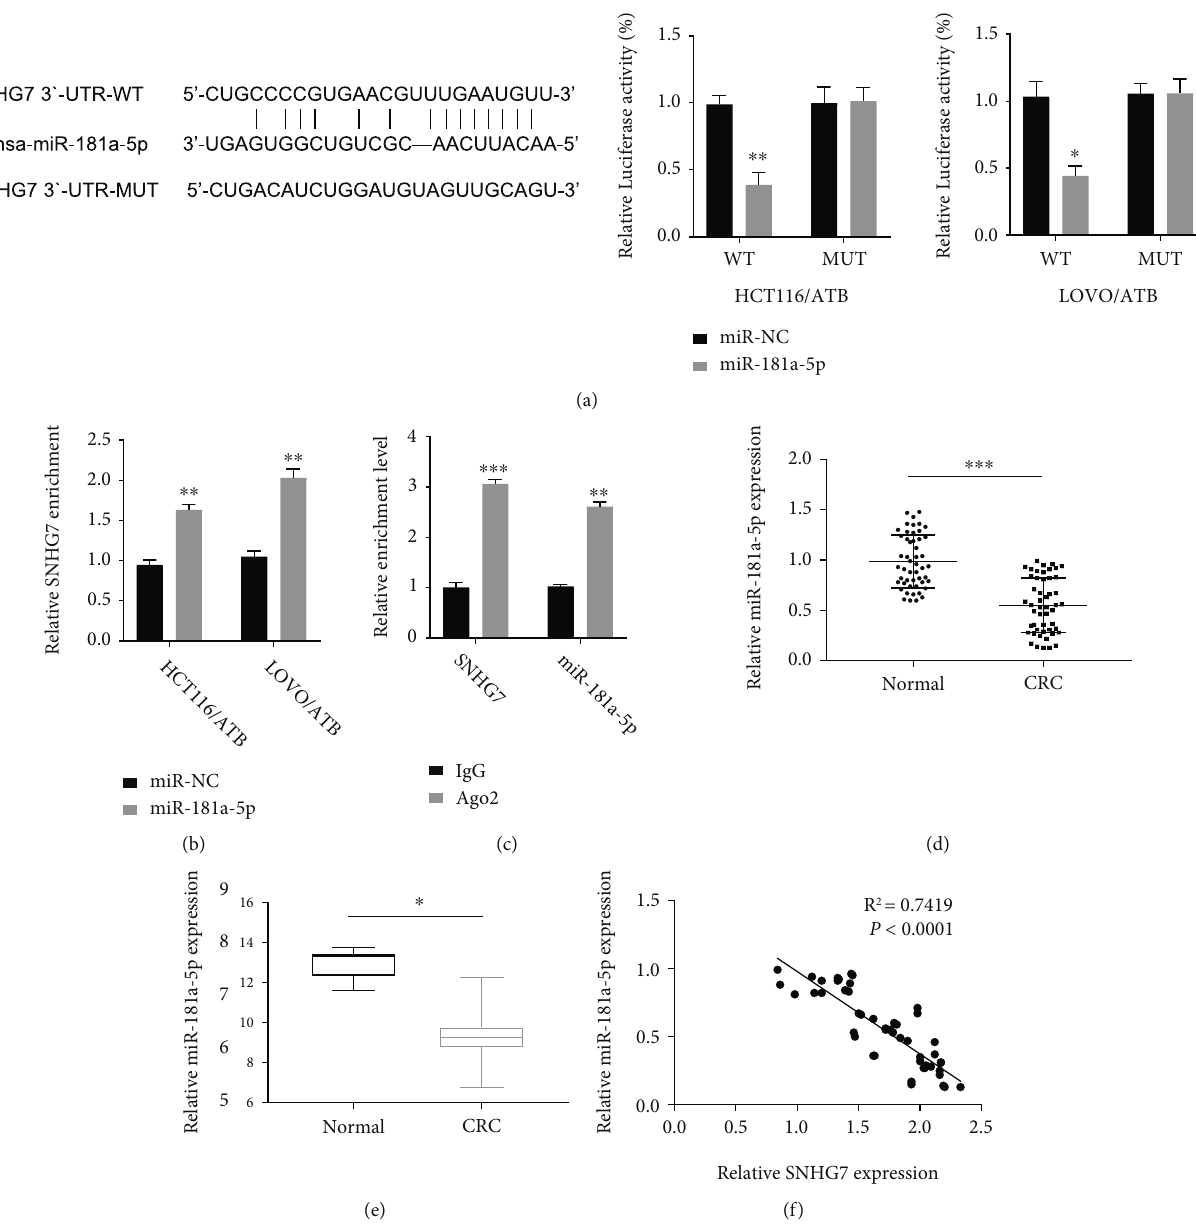
Figure 3: MiR-181a-5p is directly regulated by SNHG7. (a) Potential binding site of miR-181a-5p in SNHG7 predicted by StartBase3 and con fi rmed by Luciferase reporter assay in HCT116/ATB and LOVO/ATB cell lines. Overexpression of miR-181a-5p could inhibit Luciferase activity, but the inhibition was abolished when the potential site was mutated. (b) RNA pull-down assay showing that SNHG7 fragments were enriched e ff ectively using the miR-181a-5p probe in HCT116/ATB and LOVO/ATB cell lines. (c) RIP-qRT-PCR showing SNHG7 and miR-181a-5p fragments were enriched by Ago2 in HCT116/ATB and LOVO/ATB cell lines. (d) qRT-PCR analysis of the expression of miR-181a-5p in 50 pairs of CRCs and the adjacent tissues. (e) StartBase3 analysis of the expression of miR-181a-5p in the data from TCGA. (f) Spearman correlation analysis revealing a signi fi cant negative correlation between SNHG7 and miR-181a-5p in 50 CRC cases. The statistical di ff erences were evaluated by Student ’ s t -test (* P < 0 : 05 , ** P < 0 : 01 , and *** P < 0 : 001